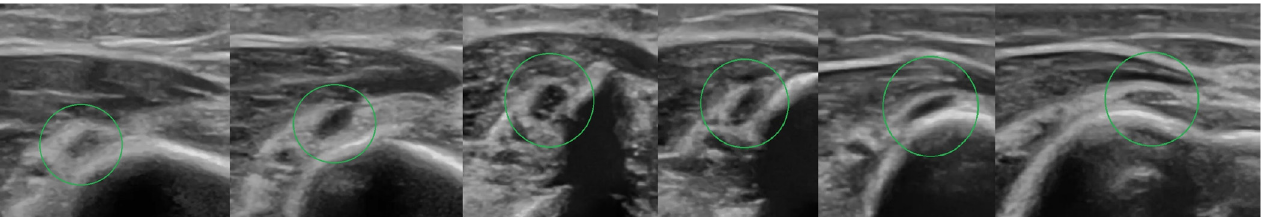
Figure 4. Patient No. 6. Subsequent ultrasound scans of transverse radial nerve sections. Abnormal hypoechogenic nature of the radial nerve found at the level of stretching between the bone fragments (the nerve and hyperechogenic outline of the humeral shaft are marked).